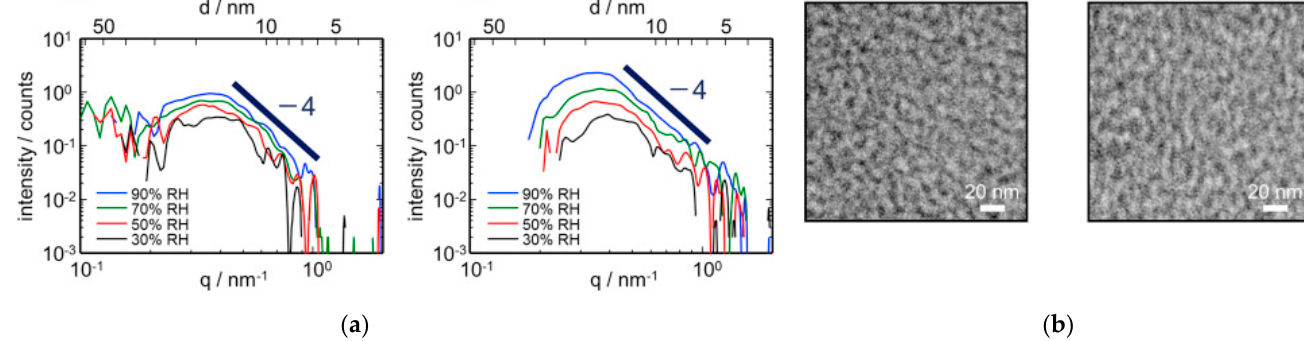
Figure 5. ( a ) Spherically shaped SAXS profile with a Porod’s slope of 4 and ( b ) its corresponding TEM image. Reprinted with permission from [89]. Copyright Elsevier,